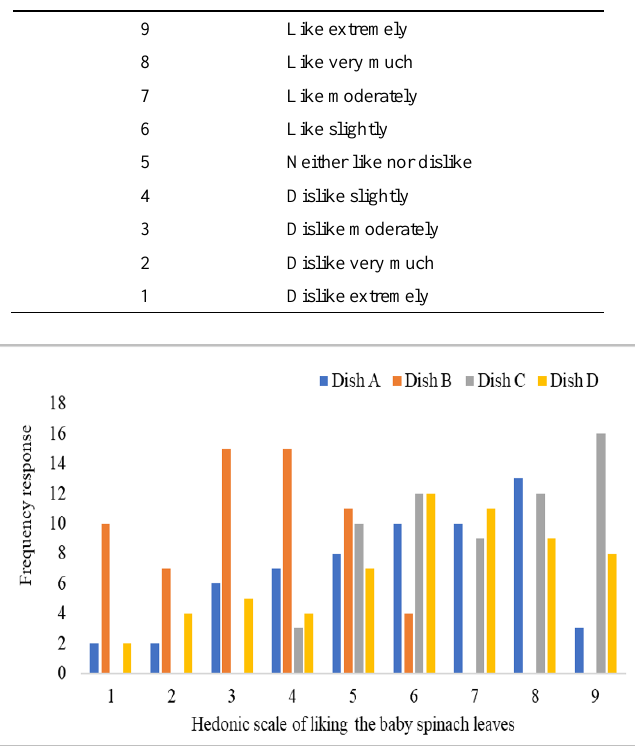
1) EC, electrical conductivity; CEC, cation exchange capacity 2) Data are means ± standard error of the means for three replicates